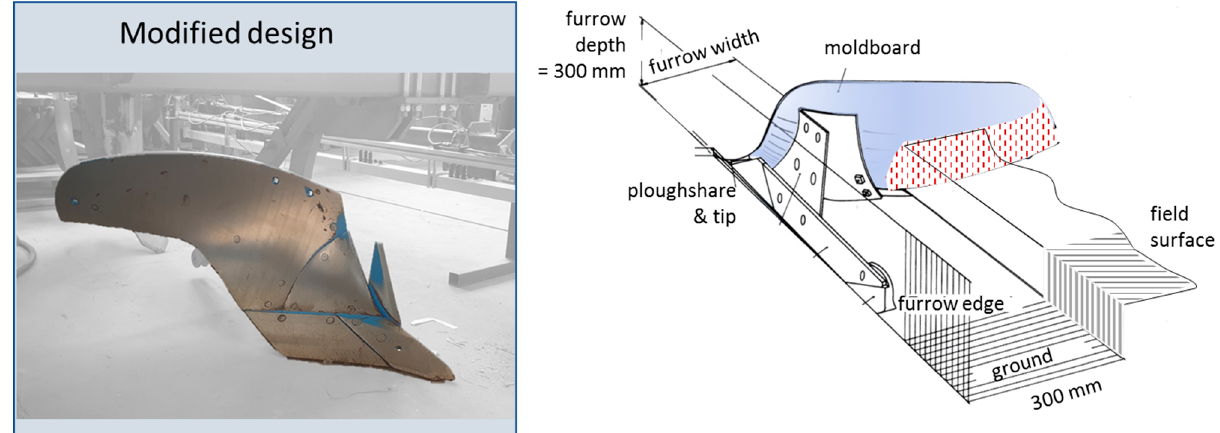
Figure 4. Modifications of the scraper blade for furrow forming.